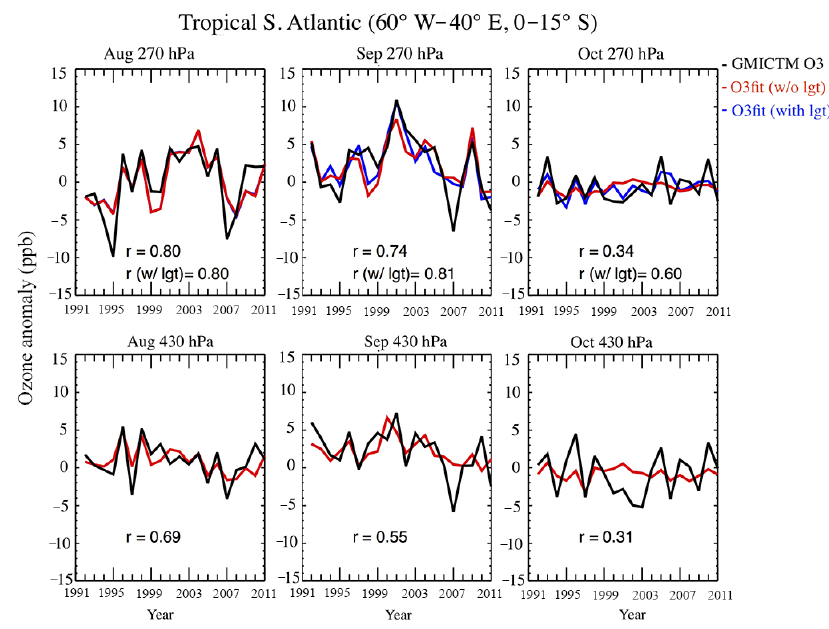
Figure 13. Comparison of the simulated ozone anomalies and the reconstructed ozone anomalies relying on two predictor variables: StratO 3 and EmissO 3 (red) over the tropical South Atlantic region at 270 and 430hPa. At 270hPa, the reconstructed ozone anomalies from three predictor variables including lightning NO x (blue) are added. Three panels show results from August (left), September (middle), and De- cember (right) from 1992 to 2011. Unit for y axis is parts per billion (ppb).